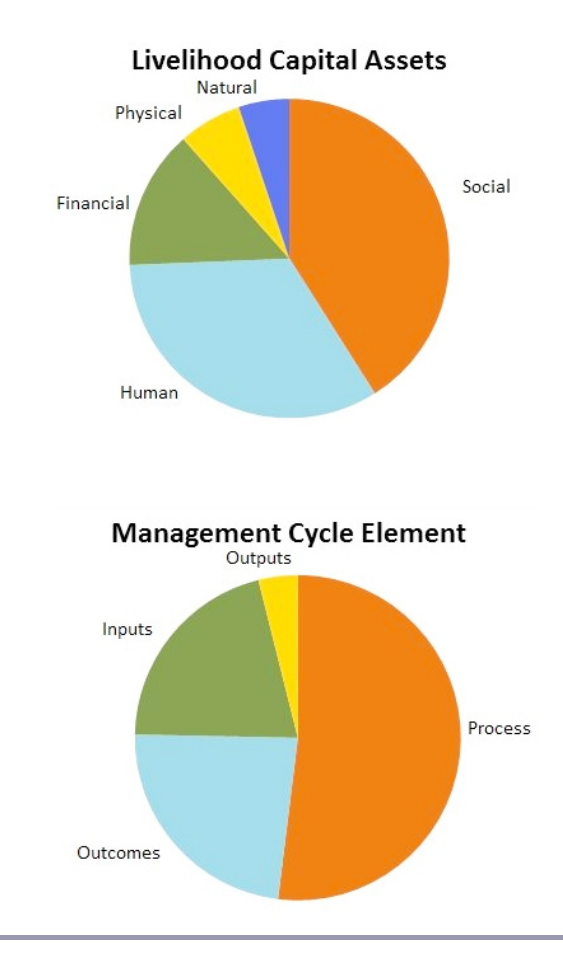
Fig. 1 . Joint management indicators categorized by sustainable livelihood capital category and elements of the protected area management